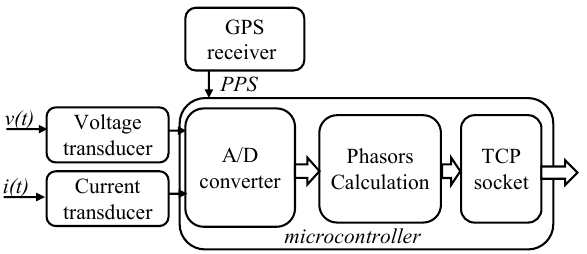
Figure 3. The proposed architecture for a low-cost Phasor Measurement Units (PMU).